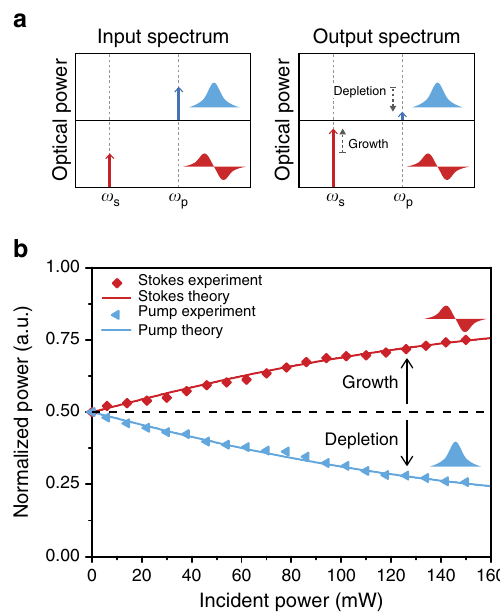
Figure 4 | Inter-modal Brillouin energy transfer. ( a ) Diagrams of input and output spectra for the energy transfer experiment. The total change in normalized signal after Brillouin coupling is denoted graphically by dashed arrows in the output spectrum. ( b ) Energy transfer fraction as a function of total incident power for one Brillouin-active